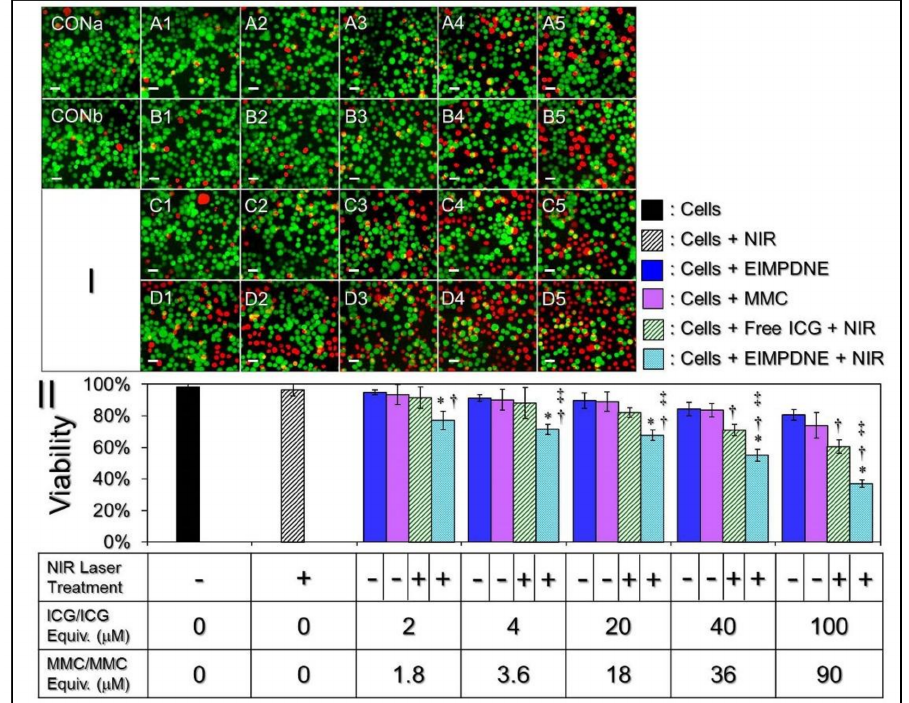
Figure 9. Cytotoxicity of the EIMPDNEs to EGFR(+) bladder cancer cells in vitro. ( I ) Photomicrographic images of T24 cells under different treatments. The rows A and B represent the groups in which the cells were co-cultured with the EIMPDNEs ( A ) or free mitomycin C (MMC) ( B ) for 24 h. The rows C and D represent the groups in which cells were pre-co-cultured with free ICG ( C ) or EIMPDNEs ( D ) for 4 h, followed by treatment with NIR irradiation (808 nm; 6 W cm − 2 ) for 5 min and incubation at 37 ◦ C for an additional 24 h. The columns 1–5 denote that the cells were treated with free ICG in 2, 4, 20, 40, or 100 µ M doses, respectively (Row C ), free MMC in 1.8, 3.6, 18, 36, or 90 µ M doses, respectively (Row B ), or EIMPDNEs with combined ICG/MMC in 2/1.8, 4/3.6, 20/18, 40/36, or 100/90 µ M doses, respectively (Rows A , D ). CONa denotes the cells with neither compound (ICG and/or MMC) treatment nor NIR exposure. CONb represents the cells treated with NIR irradiation for 5 min followed by incubation at 37 ◦ C for 24 h. The green and red cells represent live and dead cells, respectively, formed by calcein-AM/PI staining. All images were photographed by fluorescence microscopy at 200 × magnification. Scale bar = 30 µ m. ( II ) Quantitative analyses of the viabilities of T24 cells after treatment with free MMC, free ICG, or EIMPDNEs under various dosages, as indicated on the X axis. Values are mean ± s.d. ( n = 3). * p < 0.05 compared to the EIMPDNE-treated group without NIR illumination. † p < 0.05 when compared to the group with an equal dose of free MMC. ‡ p < 0.05 as compared to the group with an equal dose of free ICG and NIR